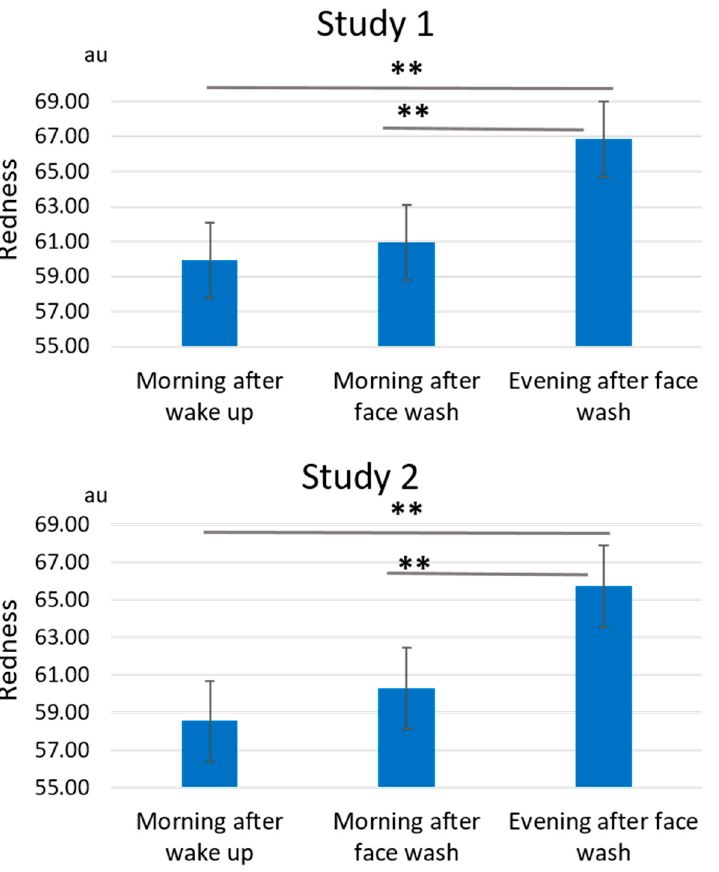
Figure 10. Daily fluctuation of redness. Facial redness is significantly larger during the evening after face wash than that during the morning after wake-up or during the morning after face wash in both Studies 1 and 2 at baseline period, week -4 to week -1. **: p < 0.01.